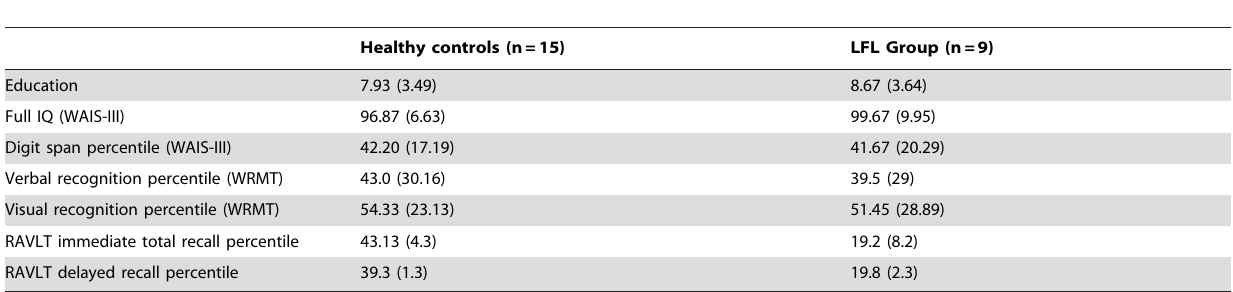
Table 2. Clinical characteristics of the LFL and healthy control subjects. Results are expressed as mean (SD).